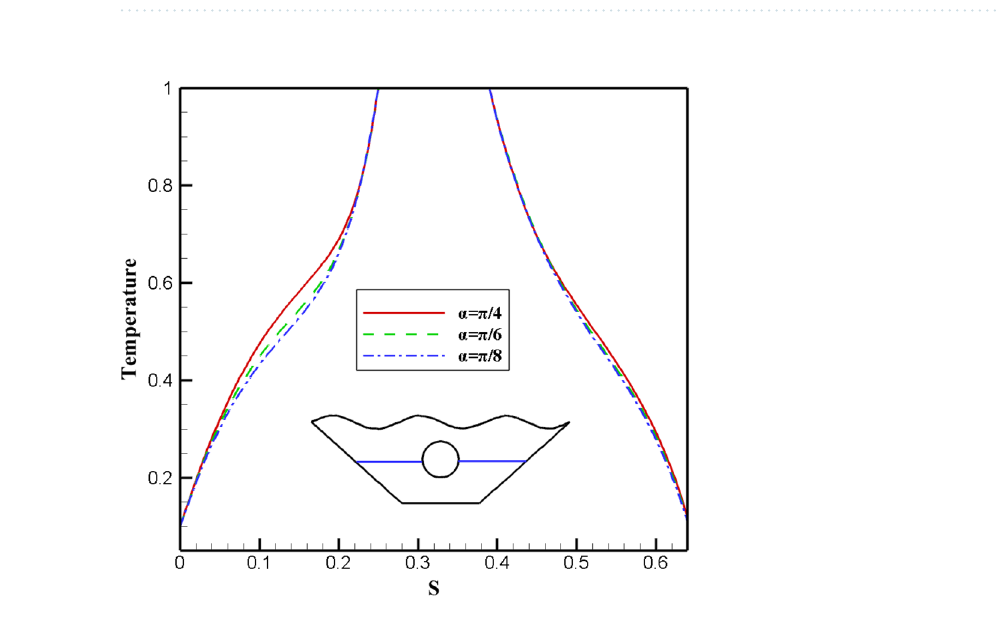
Figure 22. Temperature plot for different angle of magnetic field